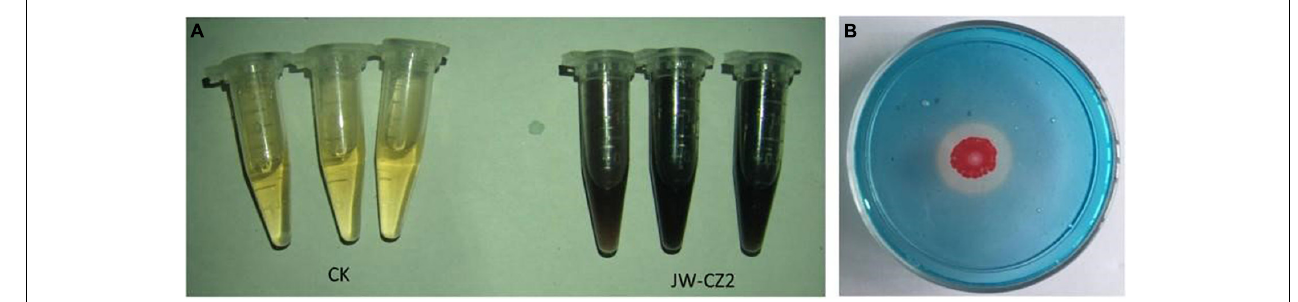
FIGURE 6 | IAA (A) and siderophore production (B) by